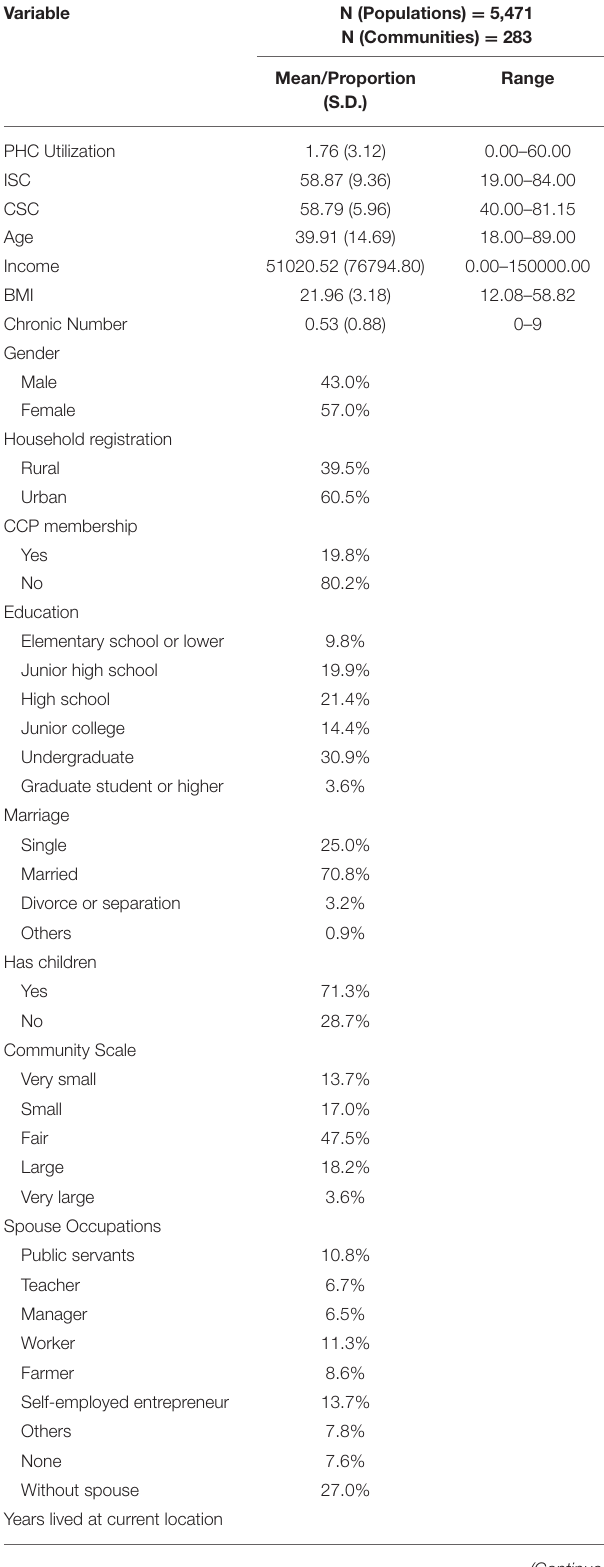
TABLE 1 | Social demographic statistics and characteristics of